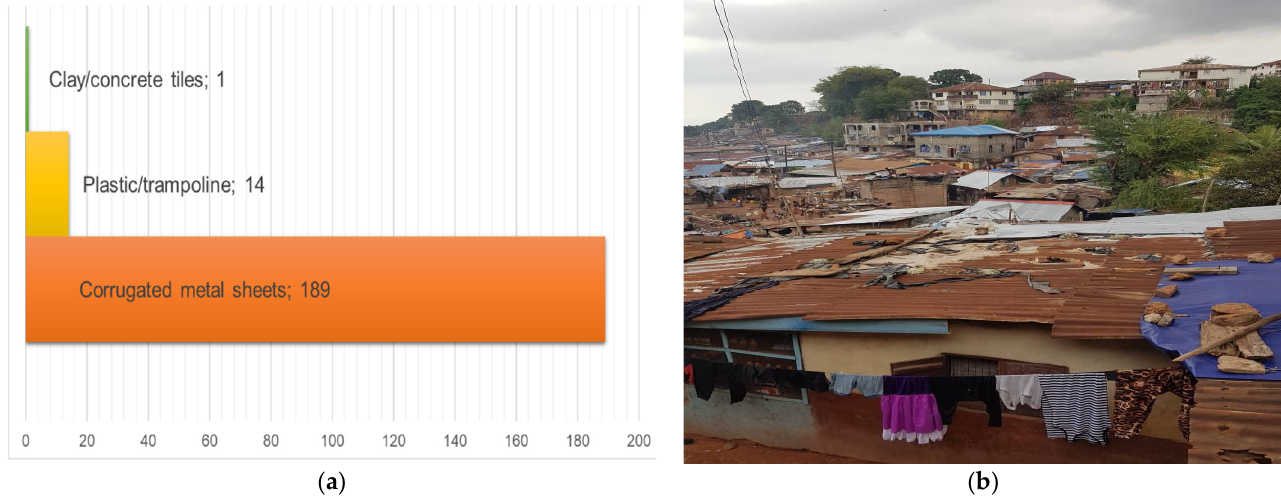
Figure 7. The Roofing system of respondents’ households ( a ). An overview of the study area rooftops ( b ). Source: Fieldwork.